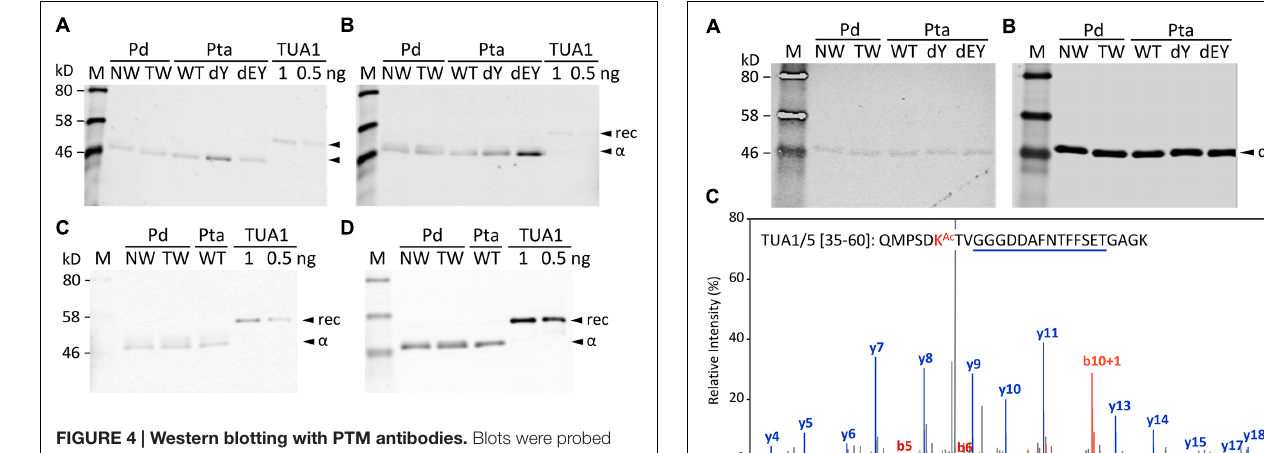
FIGURE 4 | Western blotting with PTM antibodies. Blots were probed with anti-TUA1dY (A) , anti-TUA1dEY (B) , anti-glutamylation (C) or anti-TUA (D) antibodies. Tubulin-enriched extracts from NW and TW of P. deltoides (Pd), NW of P. tremula × alba (Pta) WT and transgenic (dY or dEY) plants, or recombinant TUA1 (rec) were used. Specific signals for detyrosinated and non-tyrosinated TUA1 were only detected in transgenic dY and dEY plant extracts, respectively. Signals from the anti-glutamylation antibody were seen for the recombinant TUA1 and were deemed non-specific.